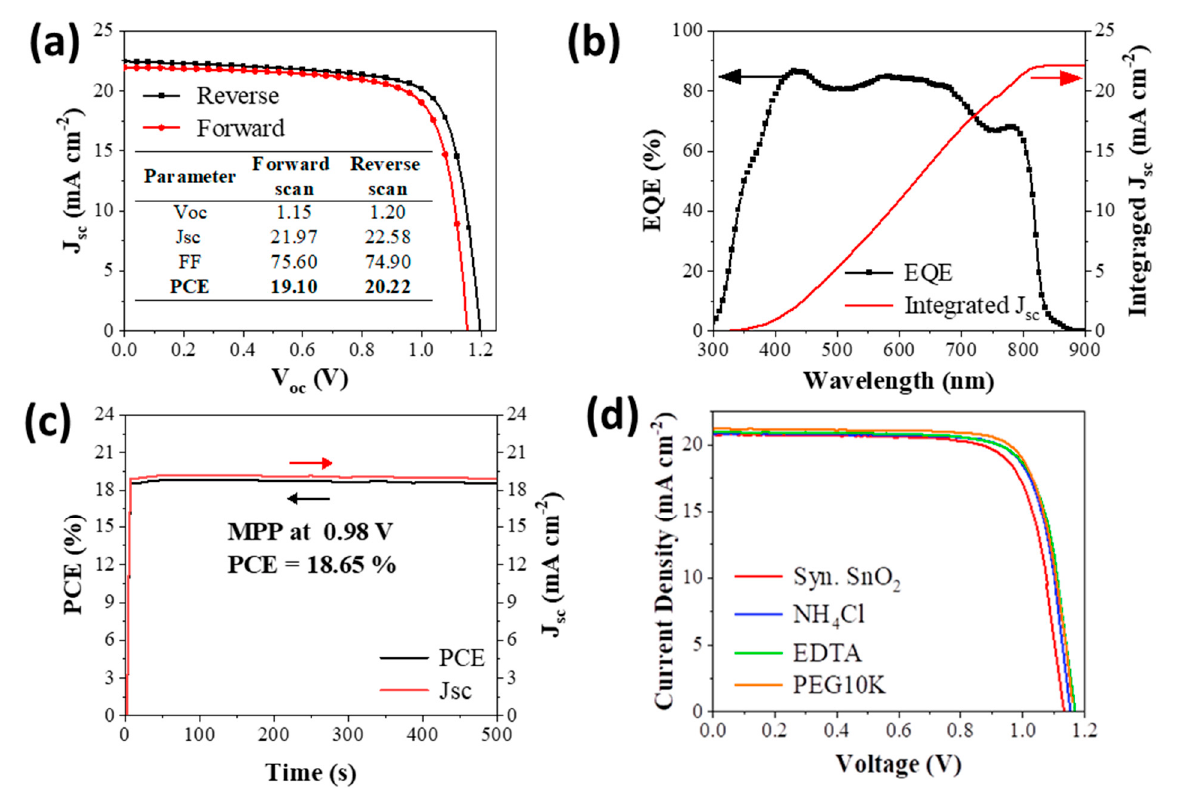
Figure 5. ( a ) J-V characteristics, ( b ) IPCE spectra, ( c ) maximum power point (MPP) tracking over time of an average glass-based device, and ( d ) J-V characteristics of PSCs (glass/ITO/SnO 2 /Cs 0.06 FA 1.11 MA 0.20 Pb 1.40 I 3.55 Br 0.62 /Spiro-OMeTAD/Au) with ETL spin coated using either pristine synthesized SnO 2 or synthesized SnO 2 with NH 4 Cl (1ppm), EDTA (0.1ppm) and PEG10K(1ppm) additives.